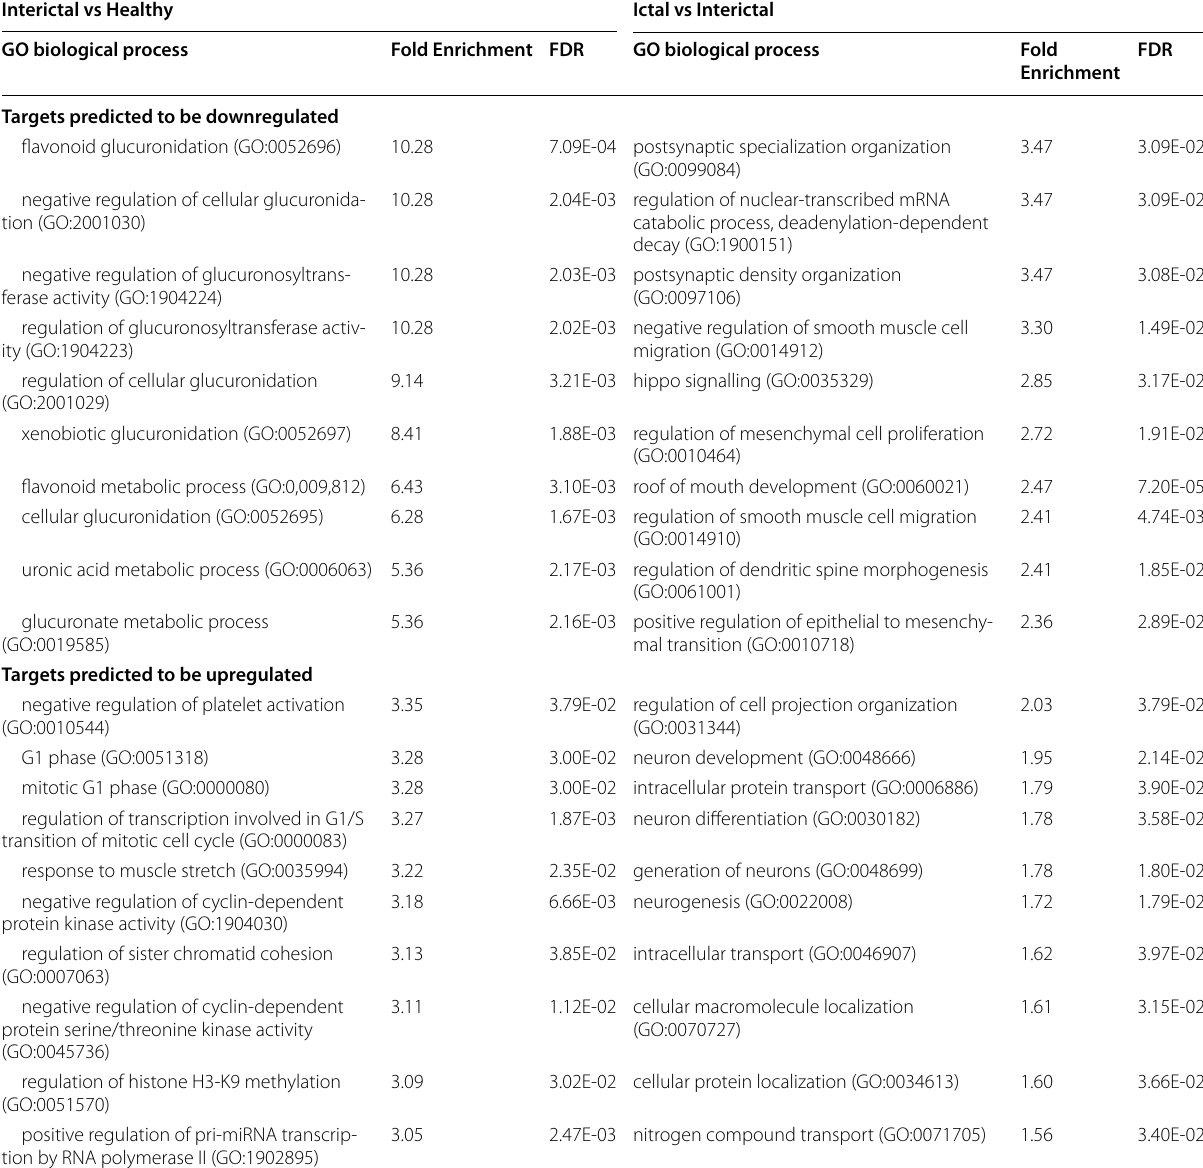
Table 7 Gene Ontology (GO) enrichment analysis (biological processes) of all miRNA targets in interictal vs healthy and ictal vs interictal comparisons. The top ten predicted up-and downregulated processes with the highest fold enrichment values are presented here, where sorting is based on the fold enrichment of the most specific subclasses Interictal vs Healthy Ictal vs Interictal GO biological process Fold Enrichment FDR GO biological process Fold